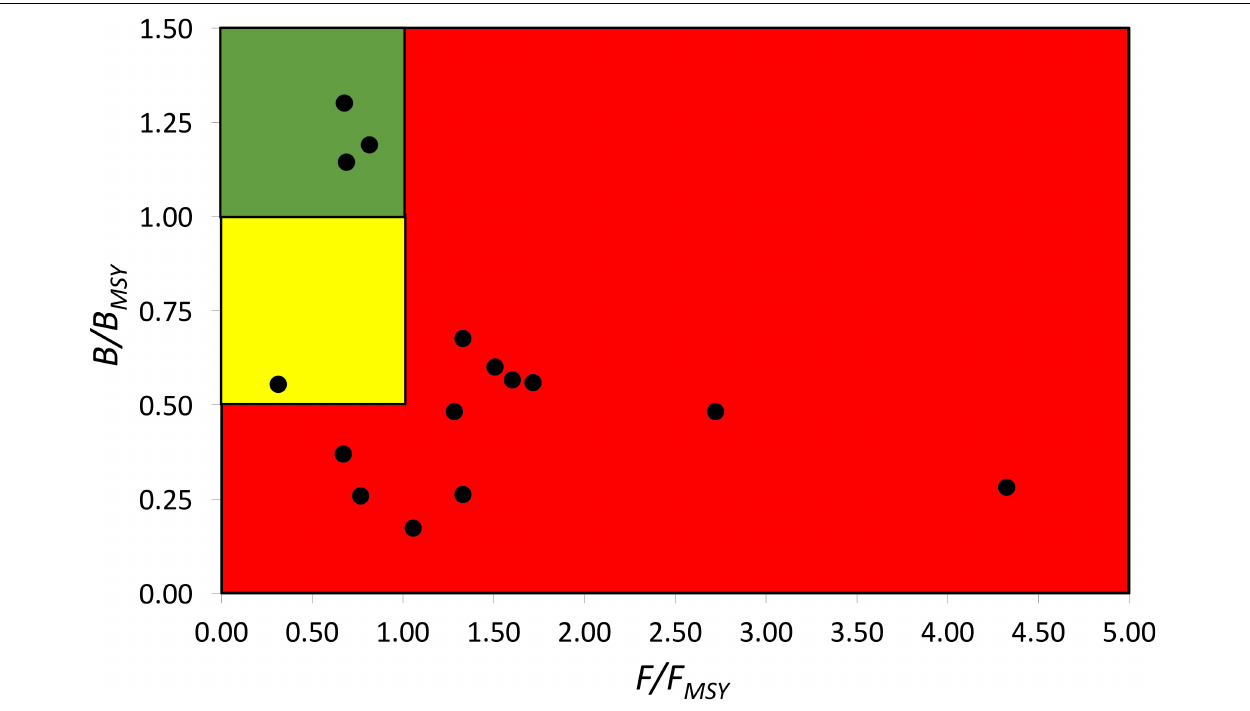
FIGURE 3 | Pressure ( F / F MSY ) – status ( B / B MSY ) plot of 15 fish stocks of China’s coastal seas for the last years with available data (2000–2017). Red area: stocks that are being overfished or are outside of safe biological limits; yellow area: recovering stocks; green area: stocks subject to sustainable fishing pressure and of a healthy stock biomass that can produce high yields close to